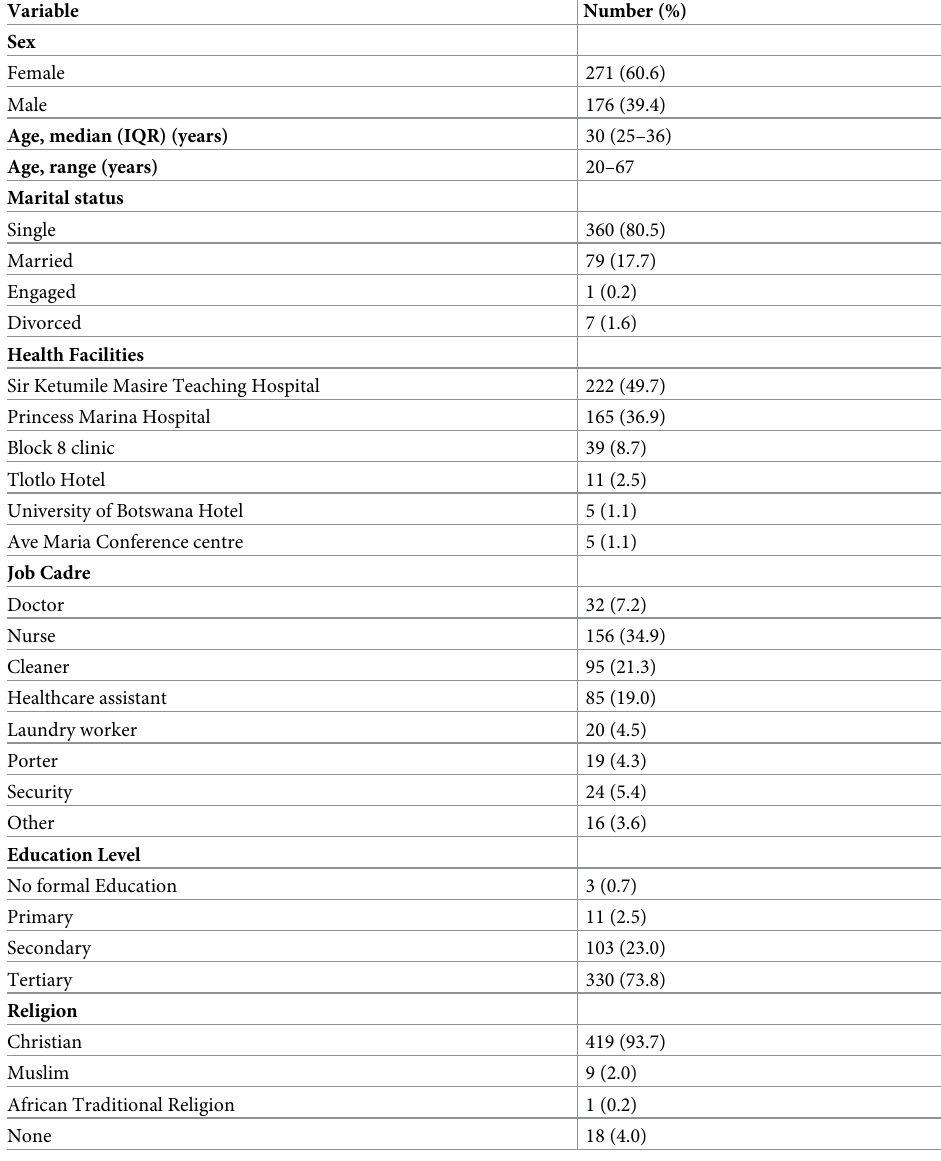
Table 1. Characteristics of participants (n =